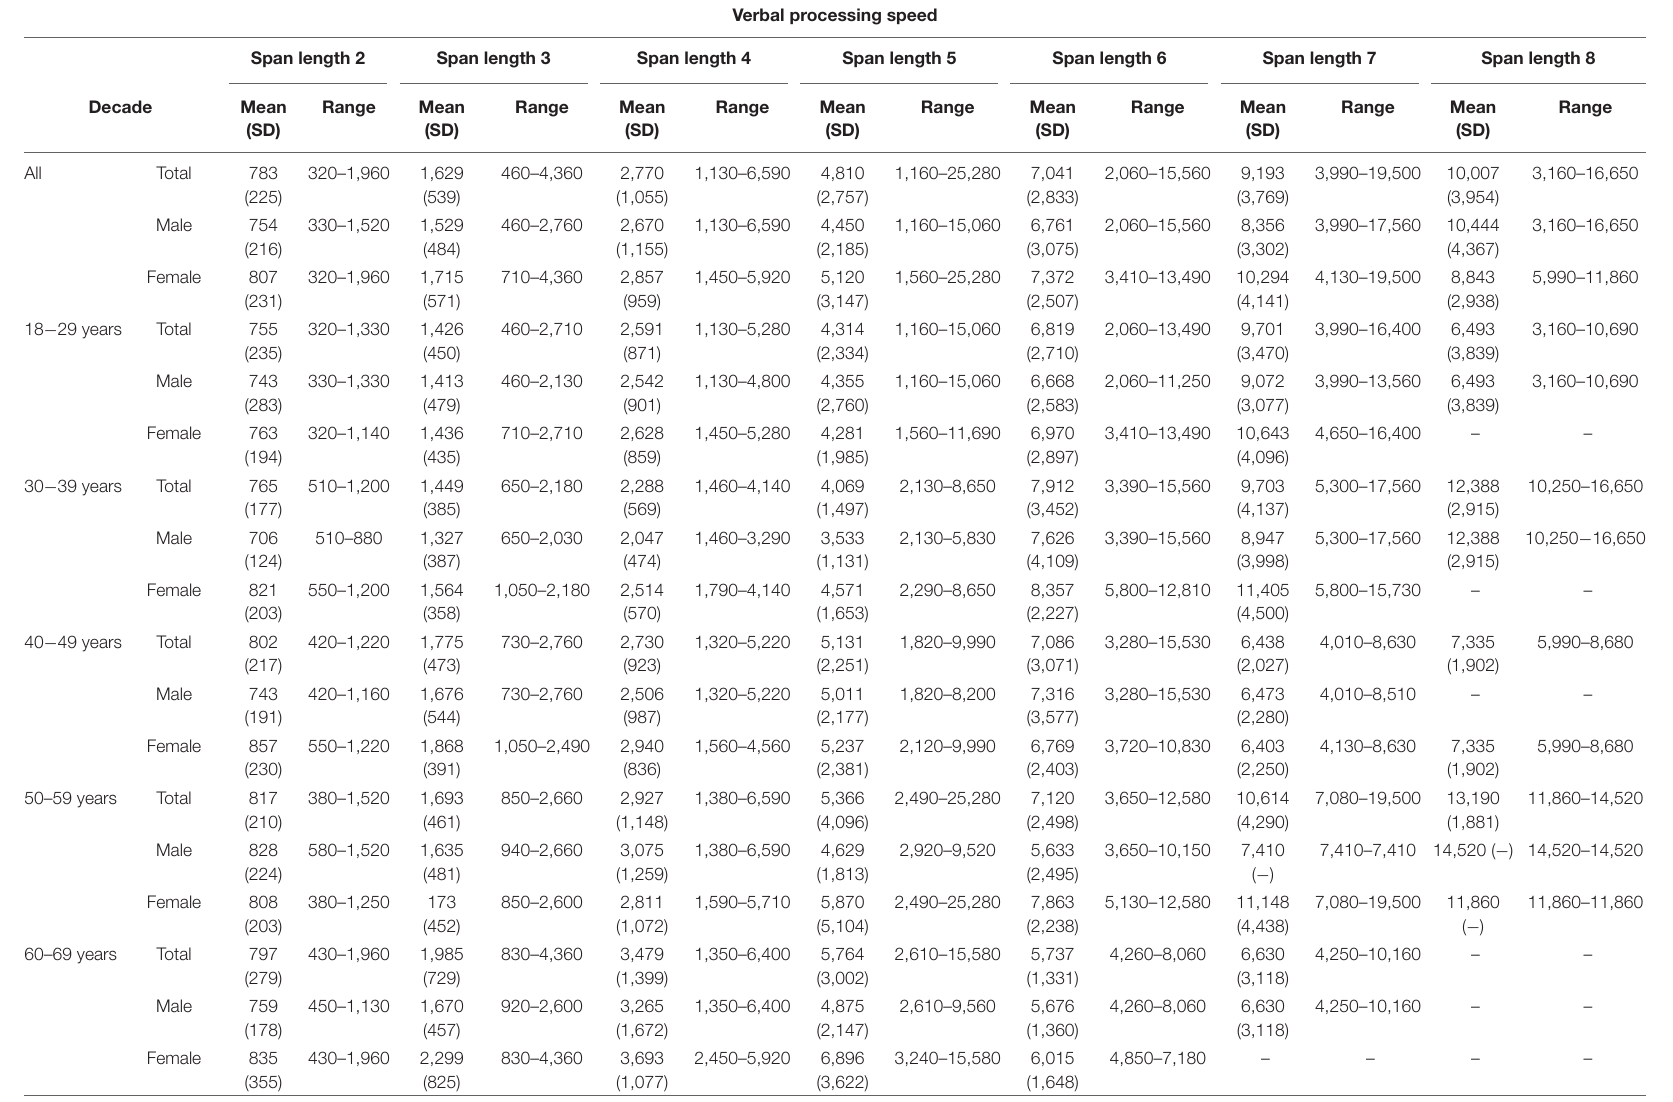
TABLE 7 | Descriptive data for verbal processing speed (ms) of the letter-number sequencing